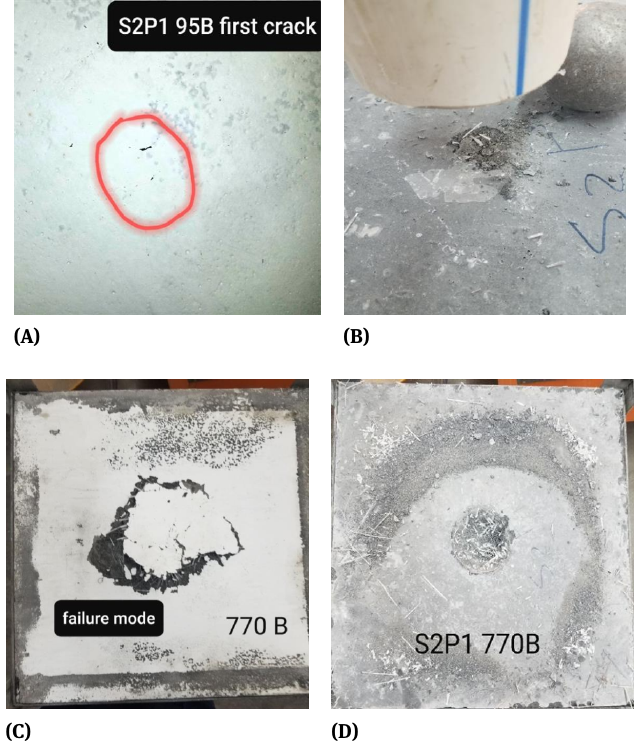
Figure 9: Face and back of impact resistance, test samples: [A] The back of SFS2P1sample in first crack; [B] The face of SFS2P1sample in first crack; [C] The back of SFS2P1sample in failure; [D] The face of SFS2P1sample in